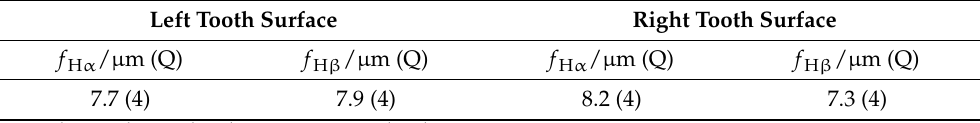
Table 5. Measurement results of the tooth profile deviations and spiral deviations. Left Tooth